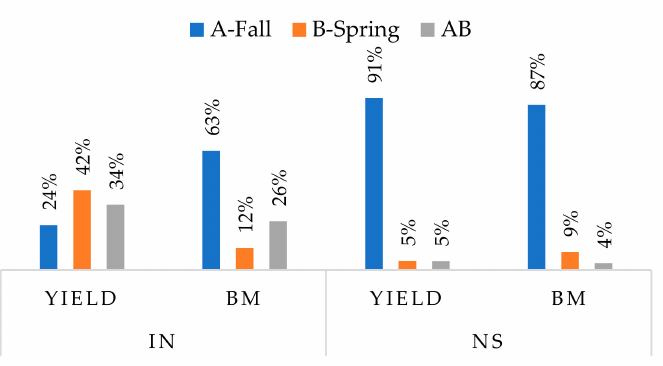
Figure 5. Contribution of partial variance of the factors (fall N fertilizer application, spring N fertilizer application) on yield and biomass of the Ingenio and NS40S varieties in 2019.